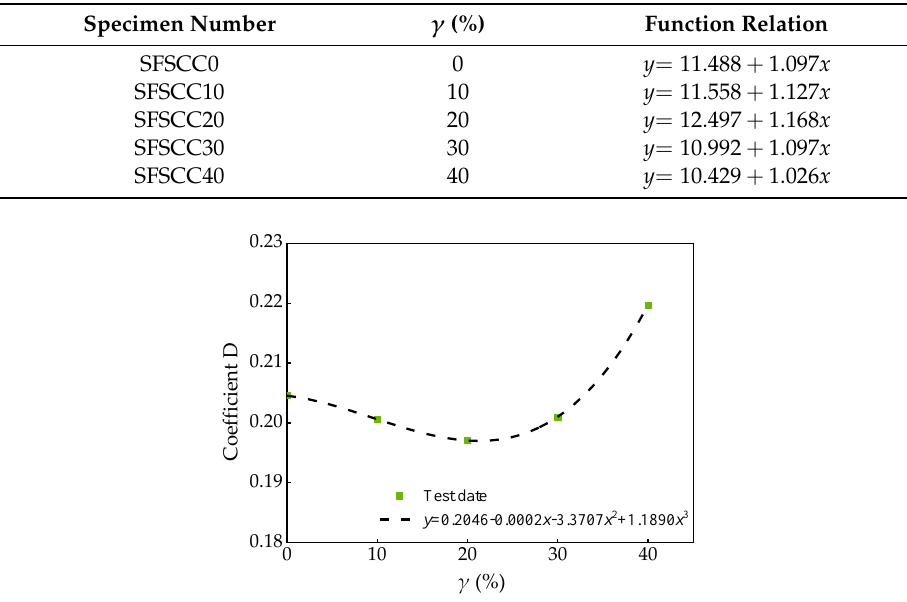
Table 11. Relation of SCC stress circle envelope function.